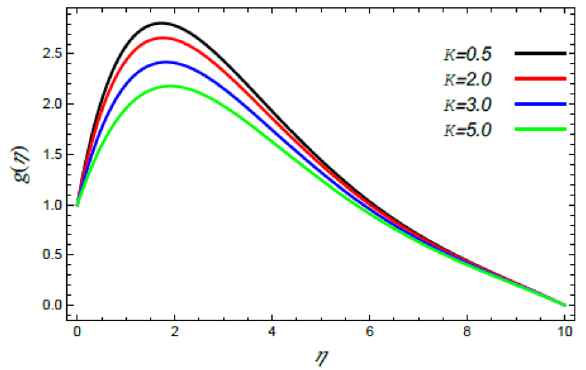
Figure 3. Deviation of the azimuthal speed g (η) versus η as given in Eq. (65) to illustrate the impact of the material factor K .